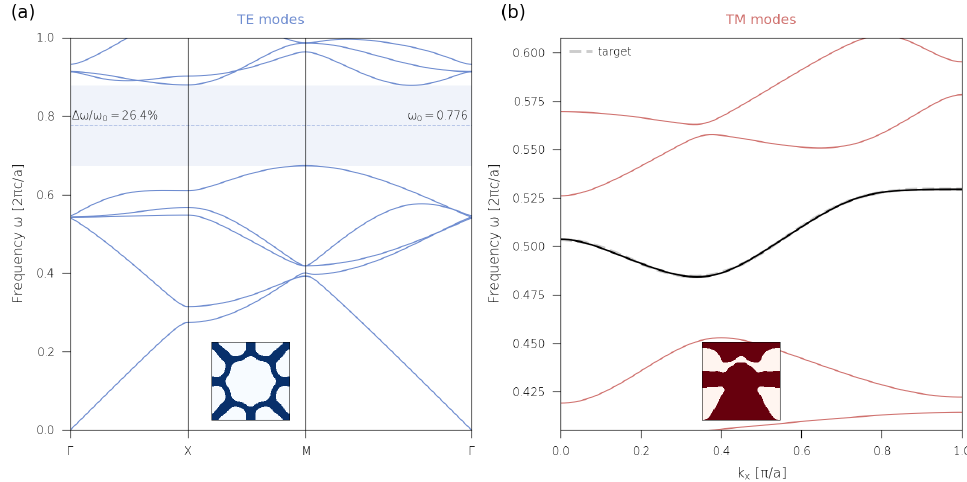
Figure 5. Inverse designed two-dimensional photonic crystals. ( a ): maximal band gap between bands 5 and 6 for TE polarization. The band diagram is computed on the edges of the first Brillouin zone, and the optimized metamaterial exhibits a relative bandgap width of around 26% centred at ω 0 = 0.766 × 2 π c / a . ( b ): dispersion engineering to obtain a prescribed target (grey dashed lines) for the 6th TM mode (black line). The insets show the optimized unit cell with air (light shades) and dielectric (dark